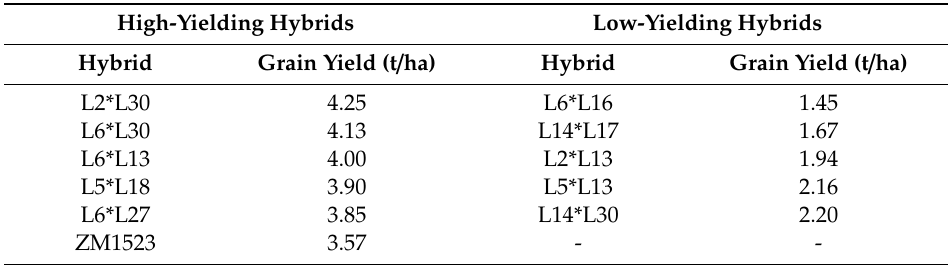
Table 8. Best and worst cross combinations for grain yield under combined drought and heat stress conditions. High-Yielding Hybrids Low-Yielding Hybrids Hybrid Grain Yield (t / ha) Hybrid Grain Yield (t / ha) L2*L30 4.25 L6*L16 1.45 L6*L30 4.13 L14*L17 1.67 L6*L13 4.00 L2*L13 1.94 L5*L18 3.90 L5*L13 2.16 L6*L27 3.85 L14*L30 2.20 ZM1523 3.57 -